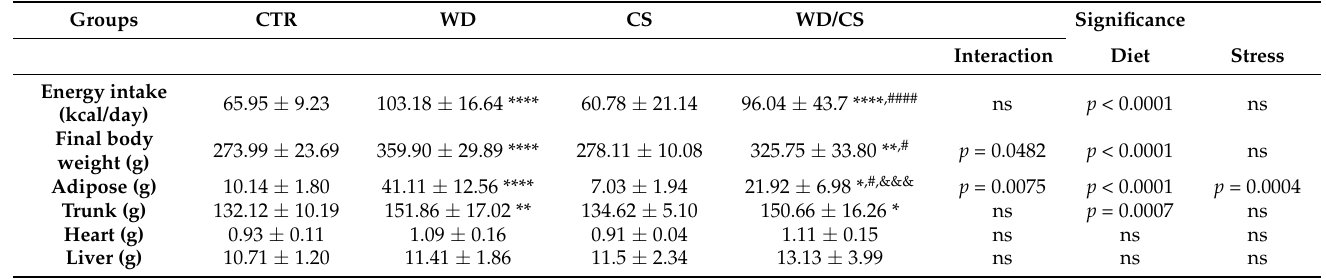
Table 1. Phenotypic parameters of rats subjected to a Western diet and/or chronic stress.